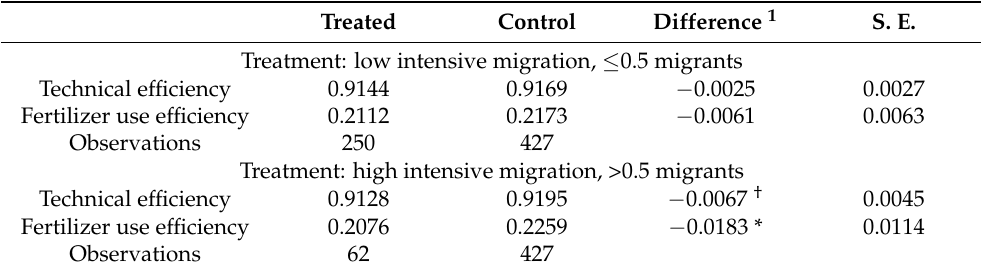
Table 3. The causal effect of migration intensity on technical efficiency and fertilizer use efficiency. Treated Control Difference 1 S. E. Treatment: low intensive migration, ≤ 0.5